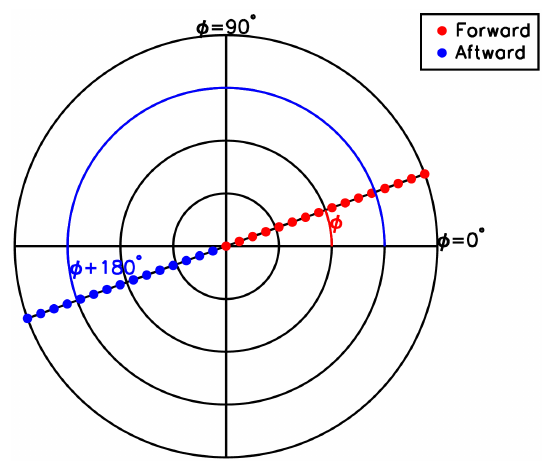
Figure 1. Idealized viewing geometry assumed to model the angu- lar dependence of RSP measurements. Each dot in the polar plot represents a single angular measurement. Forward-viewing mea- surements are represented in red, aftward-viewing measurements in